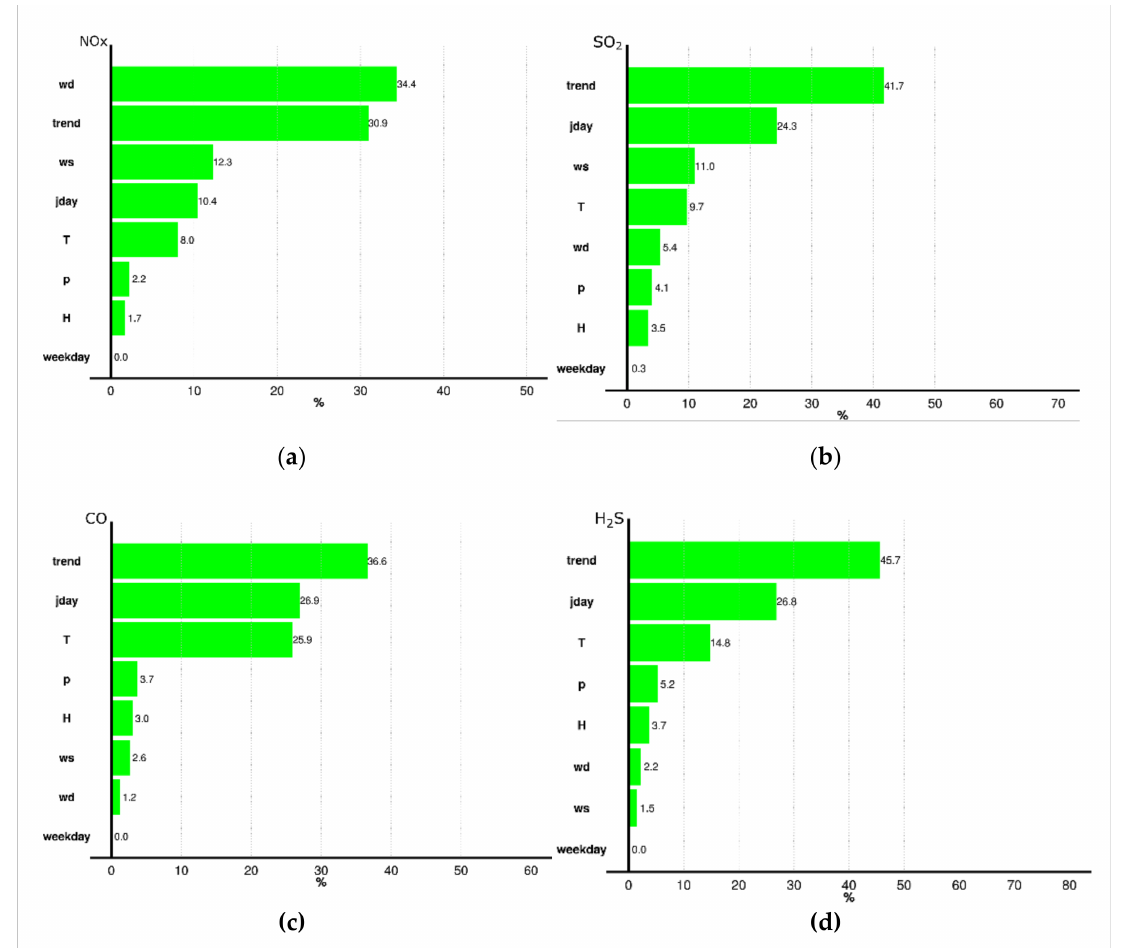
Figure 3. Relative importance of predictors for ( a ) NOx, ( b ) SO2, ( c ) CO and ( d ) H2S. The most important contribution to the NO X varbiability, instead, was due to the wind direction, closely followed by trend, and to a lesser extent by ws and jday. Therefore, it is worth looking more closely to the dependence of NO X from wd. The bivariate polar plot (Figure 4a), showing how measured NO X hourly concentrations vary by wind speed and wind direction, depicted a strong directionality of NO X concentrations associated to winds from WSW, that is in the direction of both several of the COVA plant conveyed emissive sources and the SS598 national road. The hypothesis of a traffic contribution to NO X was supported by the analysis of the daily and weekly NO X pattern (Figure 4b,c). The former tends to be significantly bimodal (higher concentrations in the early morning and late afternoon coinciding with the commuting hour). The latter shows a clear decrease of NO X concentrations on Saturday and Sunday when traffic is usually lower. Both these patterns were also confirmed by the analysis of the metadata concerning the traffic flows of cars and heavy vehicles for the national road SS598 provided by ANAS (Figure